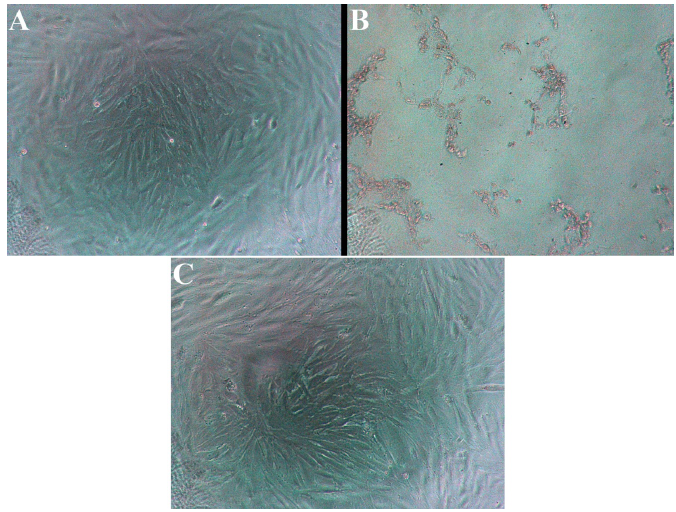
Figure 2. Microscopic images of cell cultures after 24 h treatment with: ( A ) untreated culture medium; ( B ) cigarette smoke extract at 100% extract concentration; ( C ) electronic cigarette vapour extract at 100% extract concentration (“American Tobacco”).